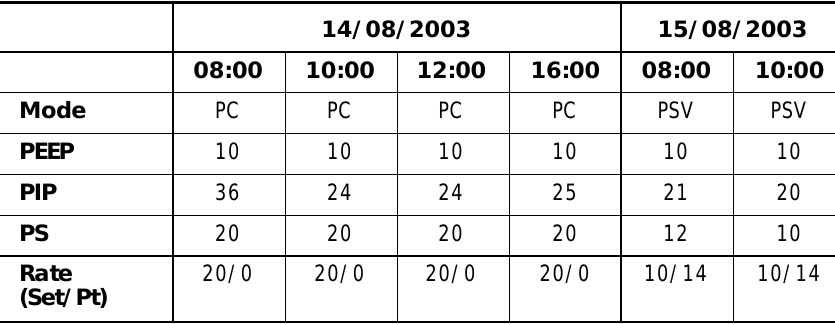
Table 2: Ventilation